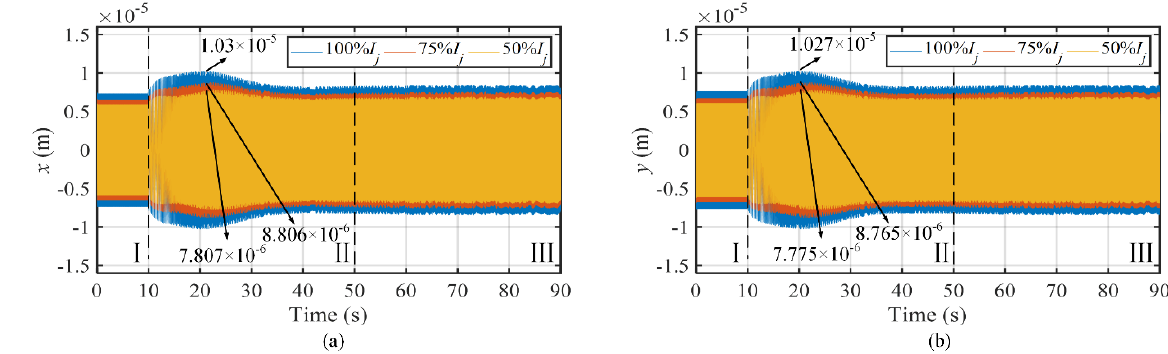
Figure 18. The time-domain figure of the generator rotor under different excitation currents. ( a ) In x -direction; ( b ) in y -direction.